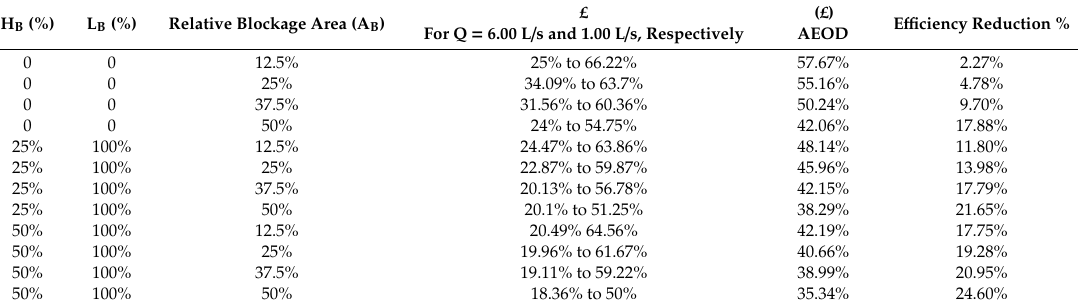
Table 3. Experimental results for various ratios of